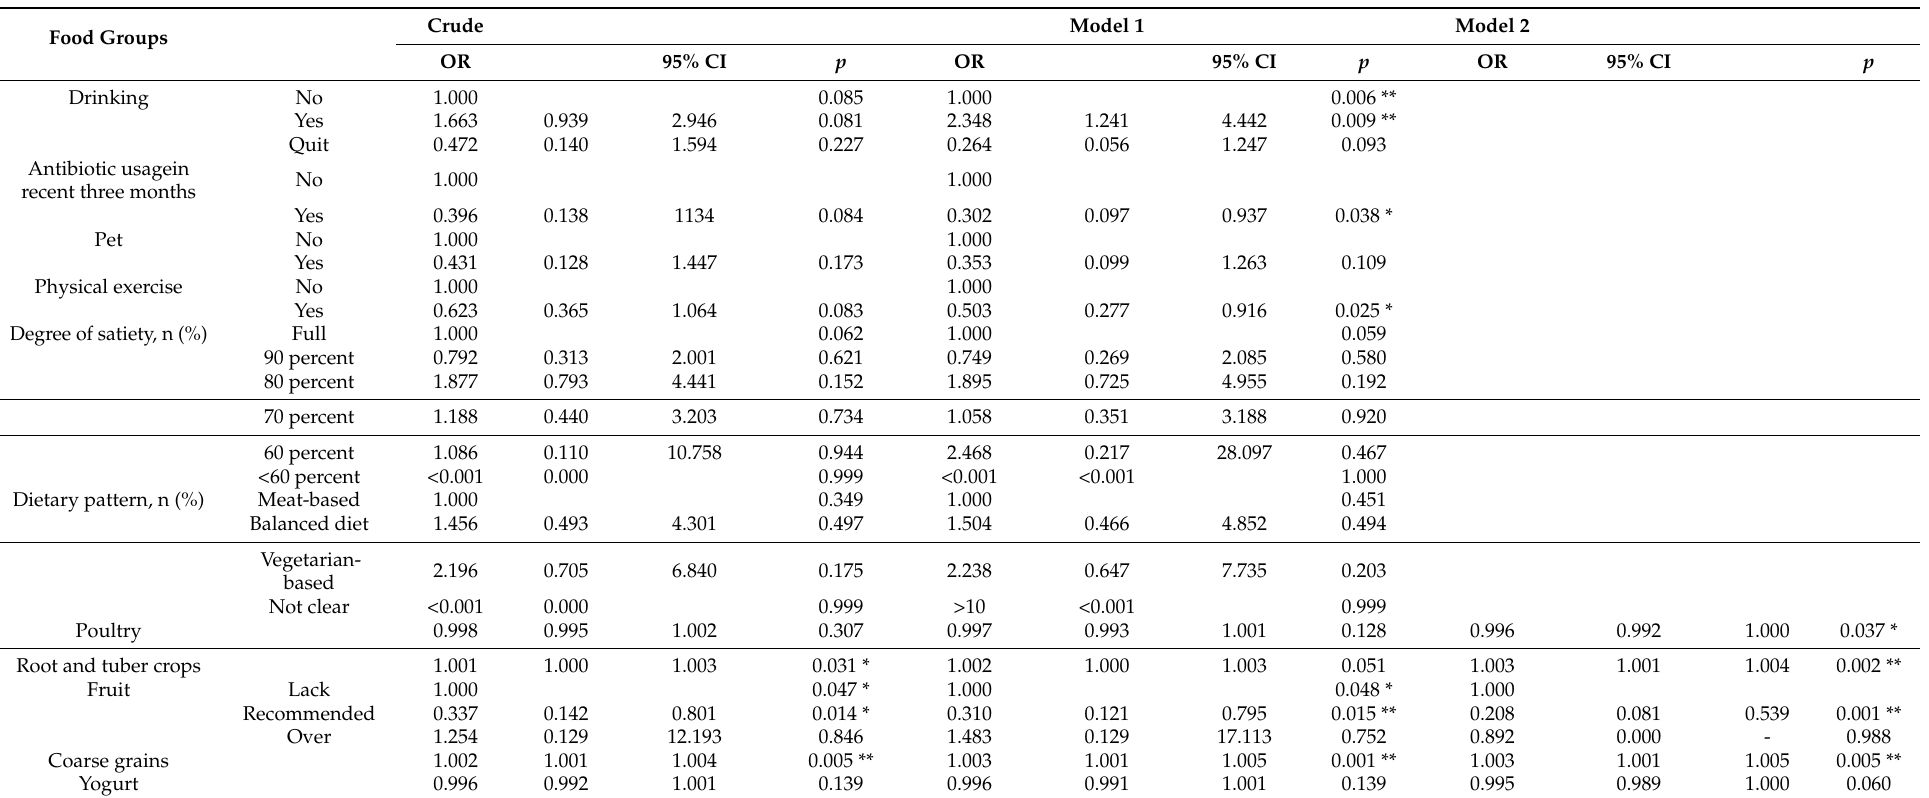
Table 3. Odds ratios (95% confidence intervals) forfecal carriage of bla NDM gene associated with dietary